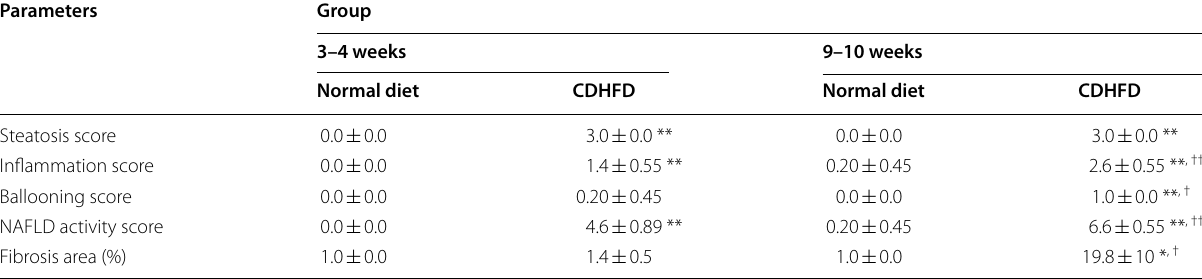
Values are expressed as means SDs ( n 5). * P < 0.05, ** P < 0.01, compared with the respective normal diet-fed groups; † P < 0.05; †† P < 0.01, compared with the 3–4- ± = week CDHFD-fed group H&E haematoxylin and eosin, SR Sirius red, CDHFD choline-deficient, low-methionine high-fat diet, NAFLD non-alcoholic fatty liver disease